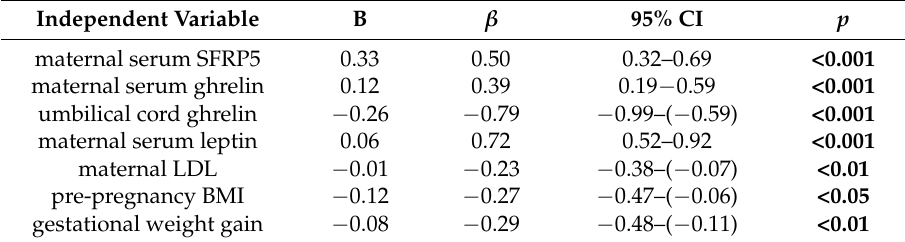
Table 3. Multiple linear regression analyses for the umbilical cord SFRP5